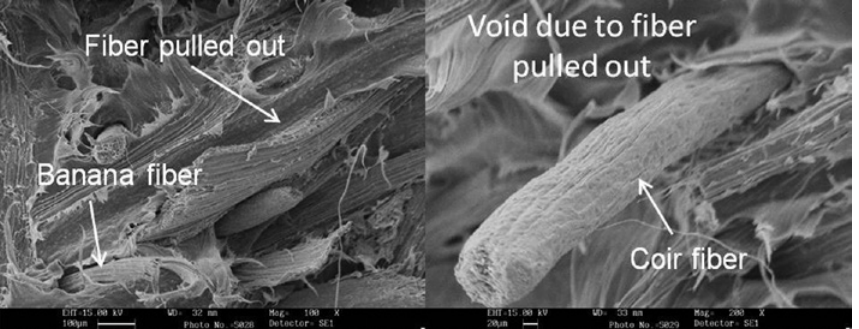
Figure 11: SEM micrograph of the tensile fracture surface of sample S4 at × 100 and × 200 magnification.